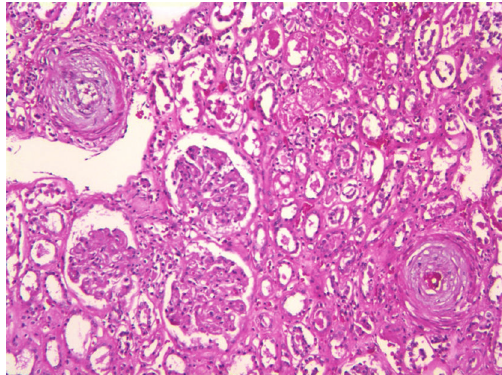
Figure 1: Hemotaxylin and Eosin stain of renal biopsy from a patient with scleroderma renal crisis, showing onion skinning concentric narrowing of arterioles with ischemia of glomeruli with flattening and degeneration of the tubular